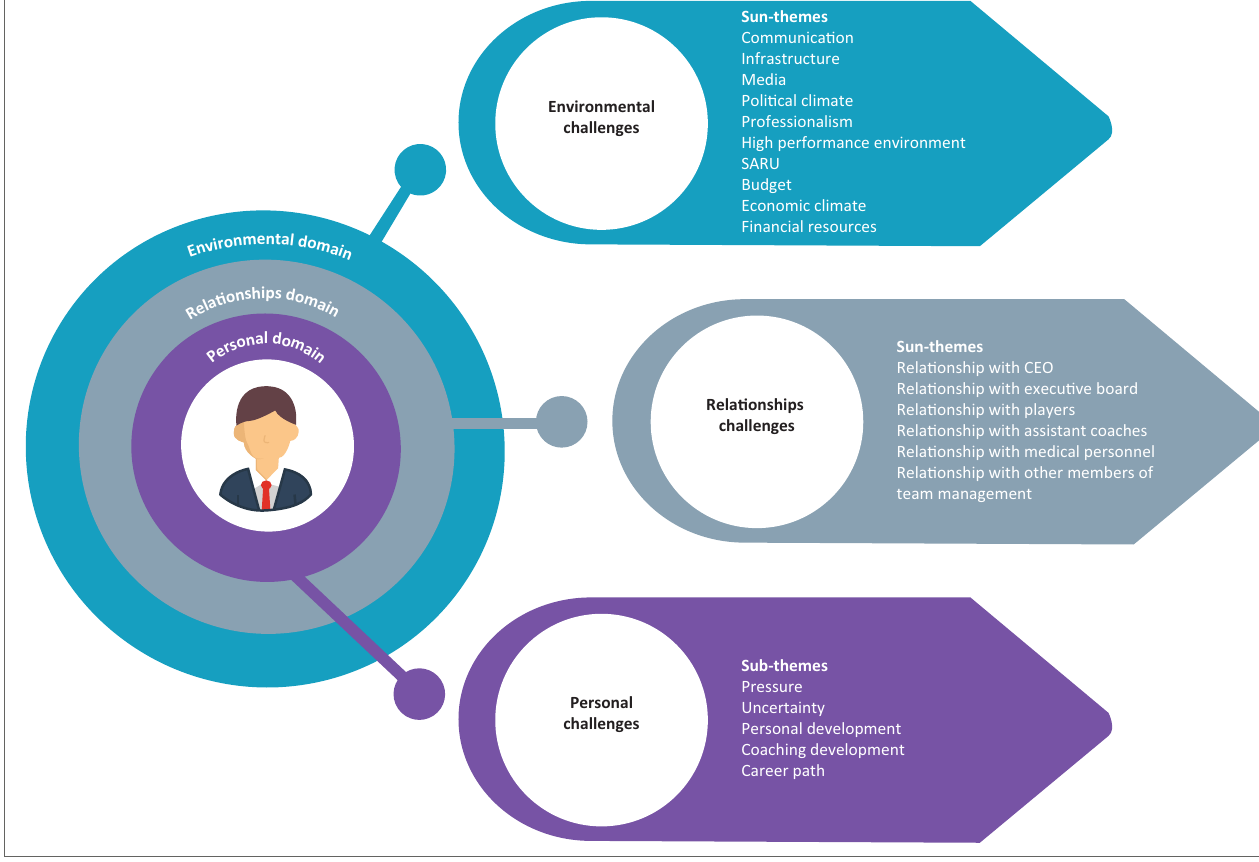
FIGURE 1: Leadership challenges experienced by elite South African rugby